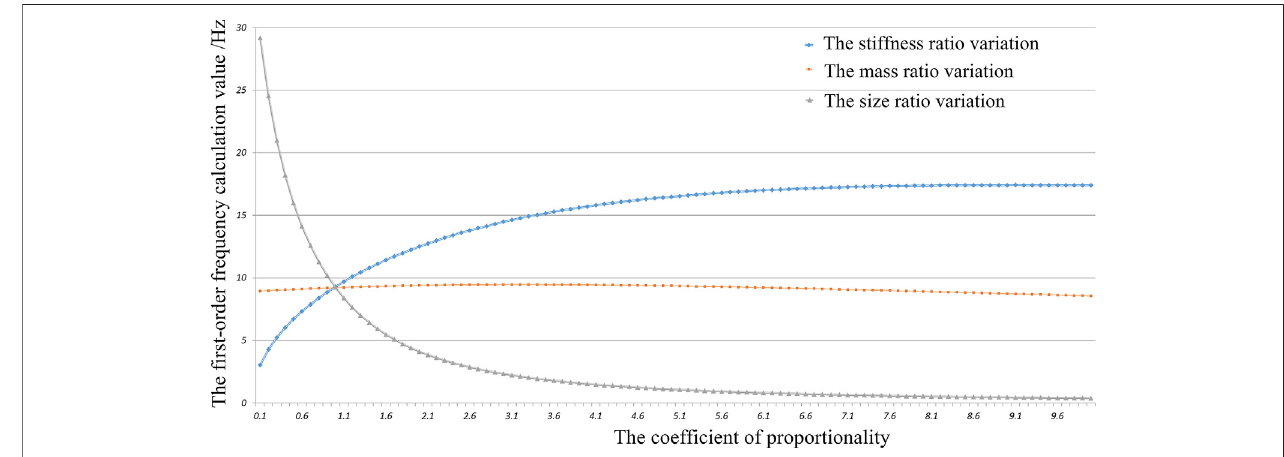
FIGURE 3 | The characteristics of the proportion of stiffness, mass, and size on the fi rst-order fundamental frequency of the system.